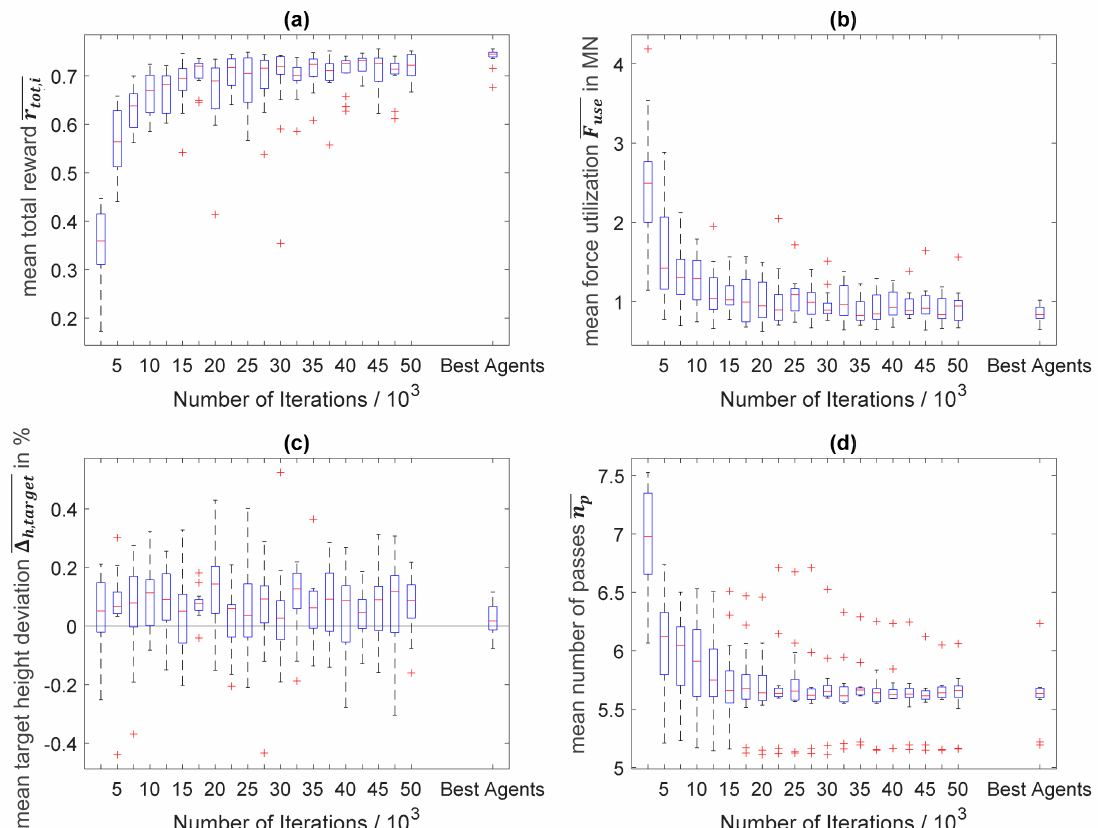
Figure 8. Boxplots of the results of all 15 Trainings over the course of the training process representing: ( a ) the mean total reward r tot , i , ( b ) the mean force utilization F use , ( c ) the mean target height deviation ∆ h , target , and ( d ) the mean number of passes n p